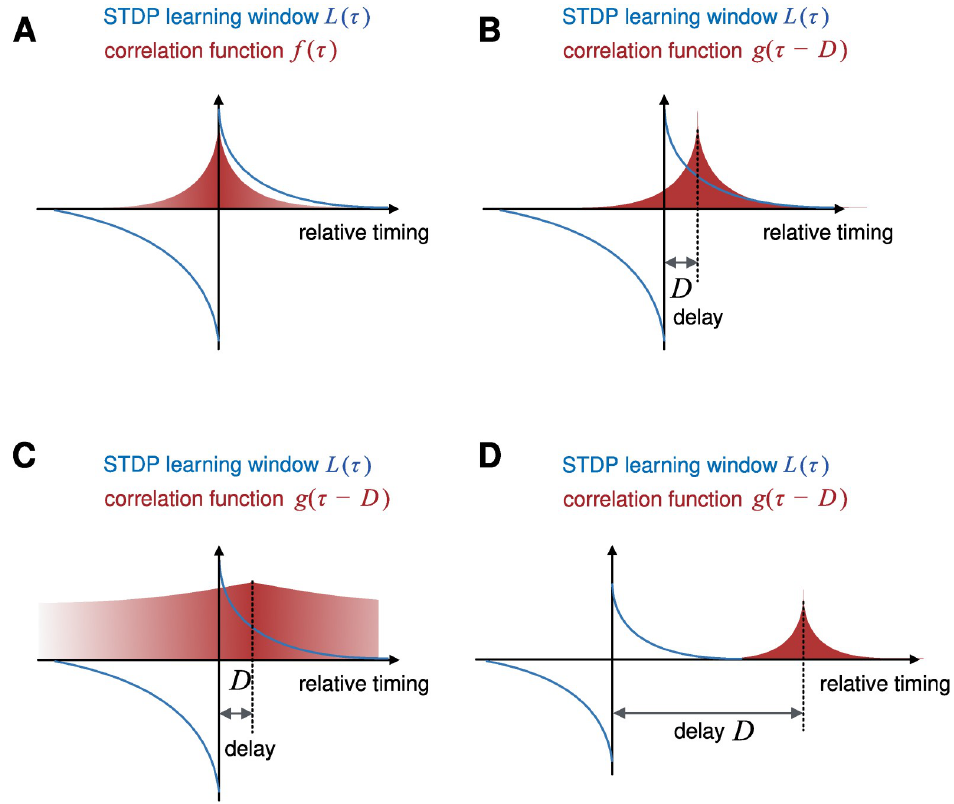
Fig 2. Interaction of temporal correlations and the STDP learning window. The weight dynamics of the direct path [Eq (6)] is driven by inputs from the direct and indirect paths: weight changes are determined by the integrated products of the STDP learning window L with the autocorrelation f [Eq (4)] and the cross-correlation g [Eq (5)], respectively. (A) Examples of a learning window L ( τ ) and an autocorrelation f ( τ ), both plotted as a function of the “relative timing” τ . For separable statistics, f is symmetric. If the learning window L has a stronger negative part for R d τ L ( τ ) f ( τ )is typically negative. (B)–(D) Learning τ < 0 and a weaker positive part for τ > 0, the coefficient A ≔ window L as in (A) and three example cross-correlations g . (B) The indirect path primarily induces potentiation in the R direct path if B ≔ d τ L ( τ ) g ( τ − D ) > 0. This is the case if (i) the delay D between the paths is positive, (ii) the learning window is positive for positive delays, and (iii) the time scale of the decay of cross-correlations g is shorter than the delay D and the width of the learning window L . These three conditions favor consolidation. (C) If the cross- correlation g decays on a time scale that is much longer than the width of the learning window and the delay D , the indirect path can drive both potentiation and depression, and consolidation is weaker (i.e., the coefficient B is smaller) than for shorter correlations. (D) If the delay D between the direct and the indirect paths is longer than the width of the learning window L , the indirect path cannot induce systematic changes in the weights of the direct path (coefficient B � 0), and consolidation is